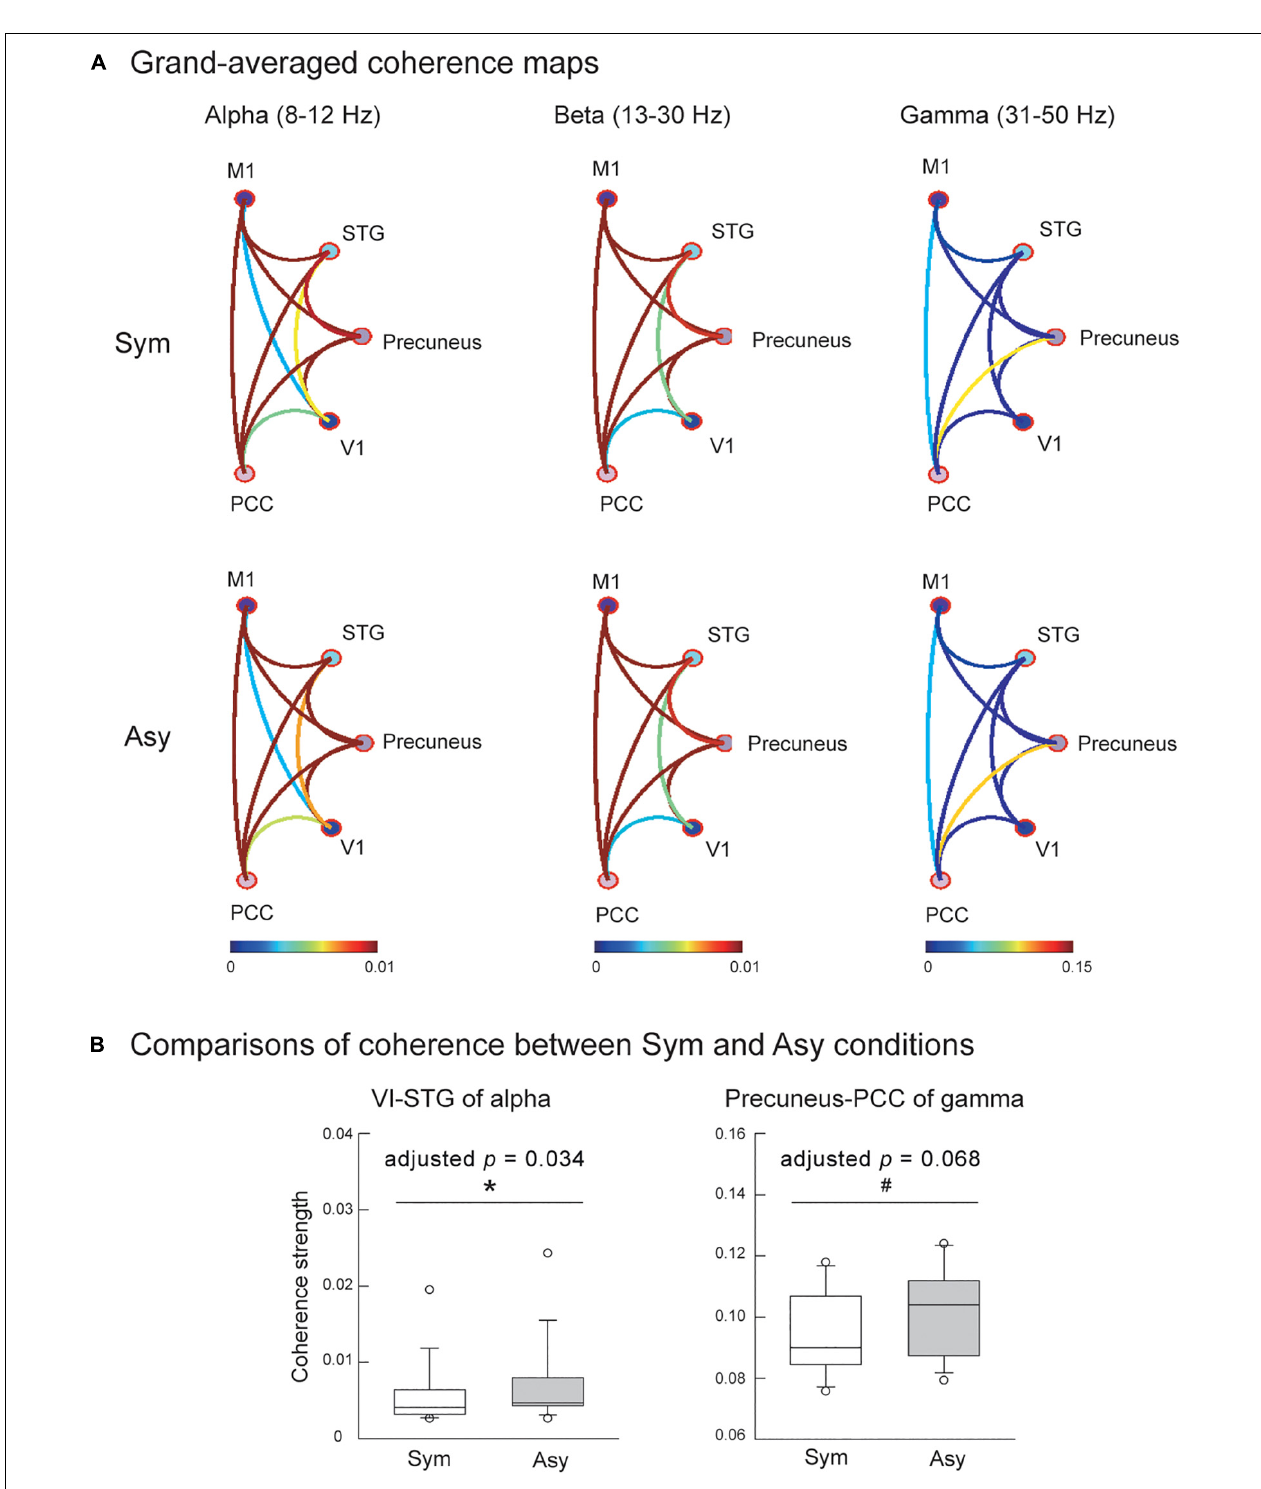
FIGURE 4 | (A) Grand-averaged functional connectivity among primary motor cortex (M1), superior temporal gyrus (STG), precuneus, primary visual cortex (V1), and posterior cingulate cortex (PCC) in the Sym and Asy conditions. Different colors of connectivity lines representing varying degrees of coherence strength. (B) The statistical results showed that functional connectivity of V1-STG (alpha band) was stronger in the Asy than in the Sym condition, and the functional connectivity of precuneus-PCC (gamma band) demonstrated a trend to be significantly stronger in the Asy than in the Sym condition. ∗ Represents significant effect ( p < 0.05); # represents marginal effect ( p <